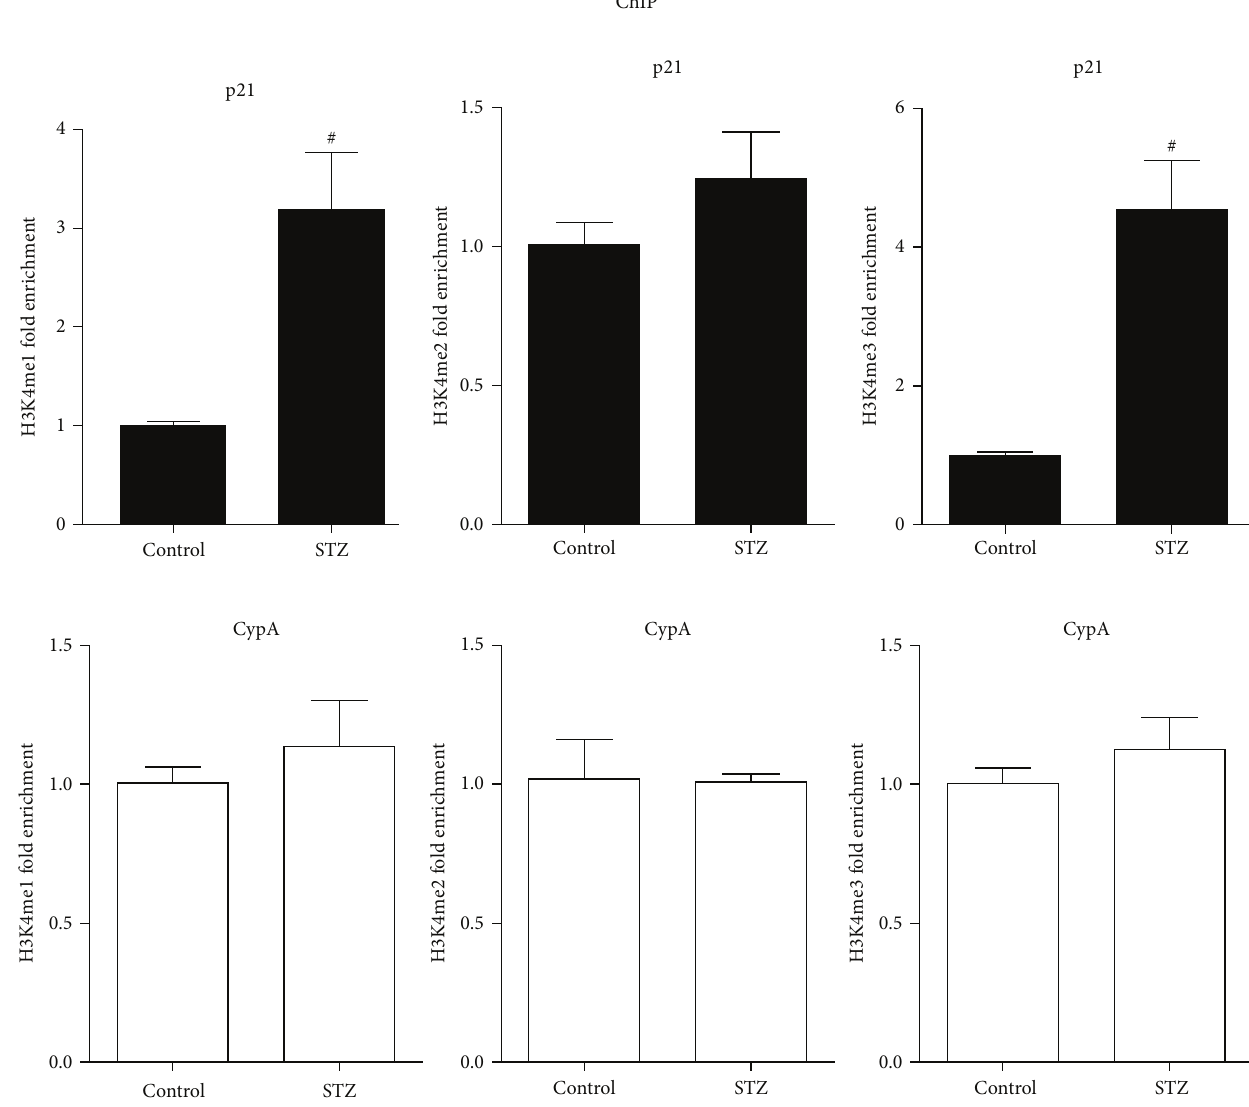
Figure 3: H3K4me1/2/3 levels at p21 gene promoter in the glomeruli of type 1 diabetic rats. H3K4me1, H3K4me2, and H3K4me3 levels at p21 and CypA promoters in glomeruli of control and STZ groups. ChIP assays were performed as described in Figure 2 with respective specific antibodies, and results normalized to input DNA were expressed as fold over the control group (mean ± SEM; # 𝑃 < 0.05 compared to